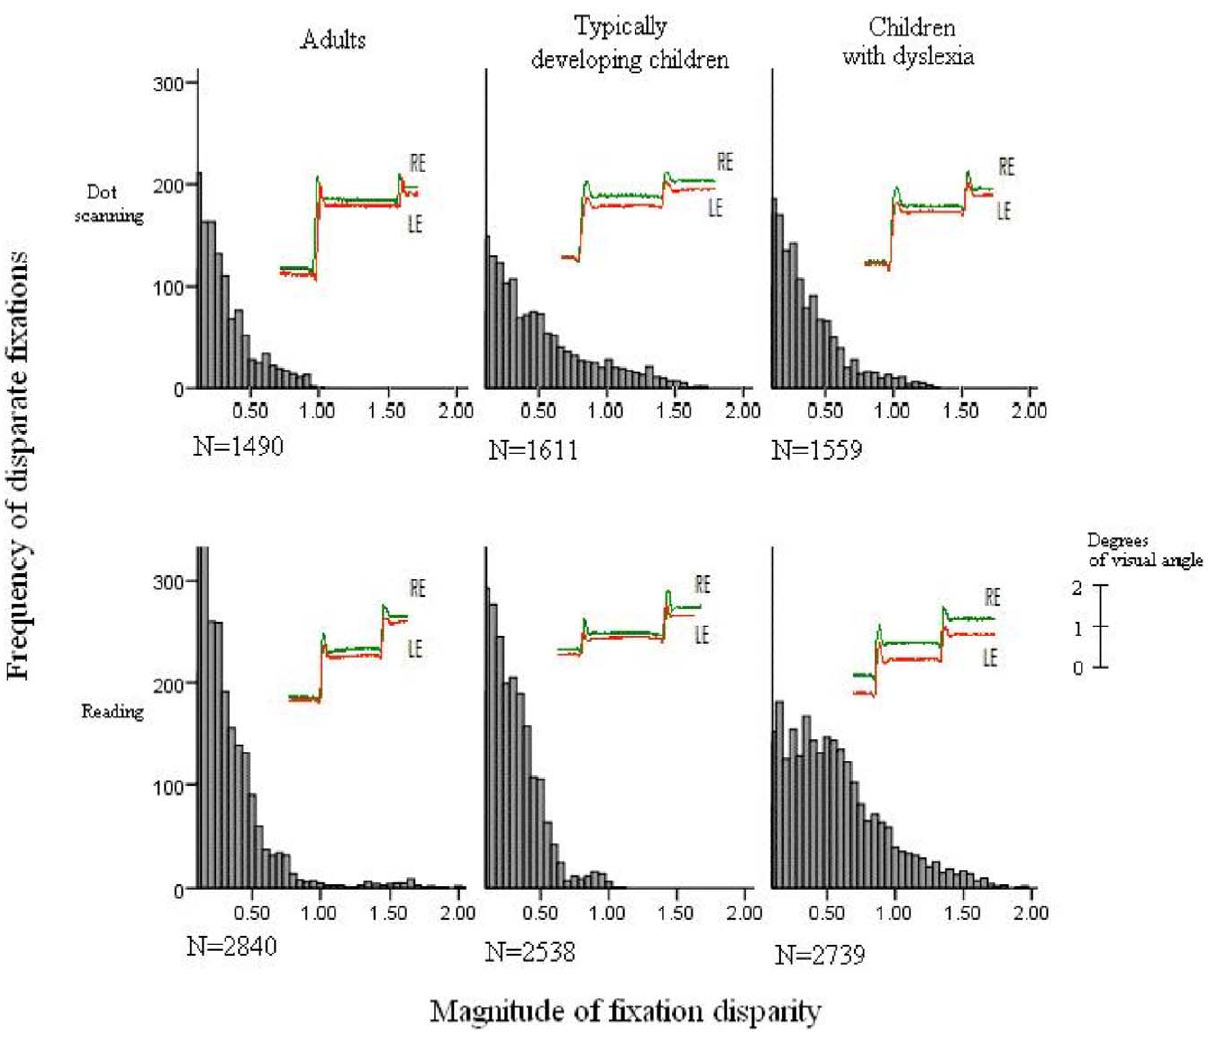
Figure 1. Frequency of disparate fixations; binocular eye movement traces representative of the mean fixation disparity for each group.